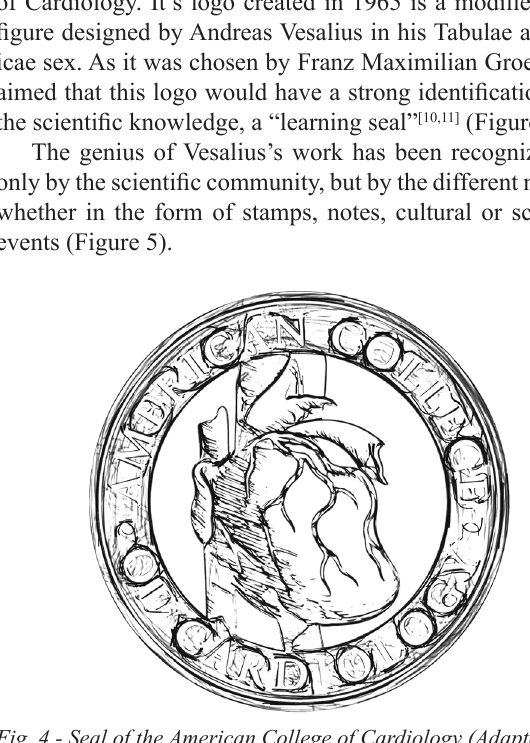
Fig. 4 - Seal of the American College of Cardiology (Adapted [11] ).